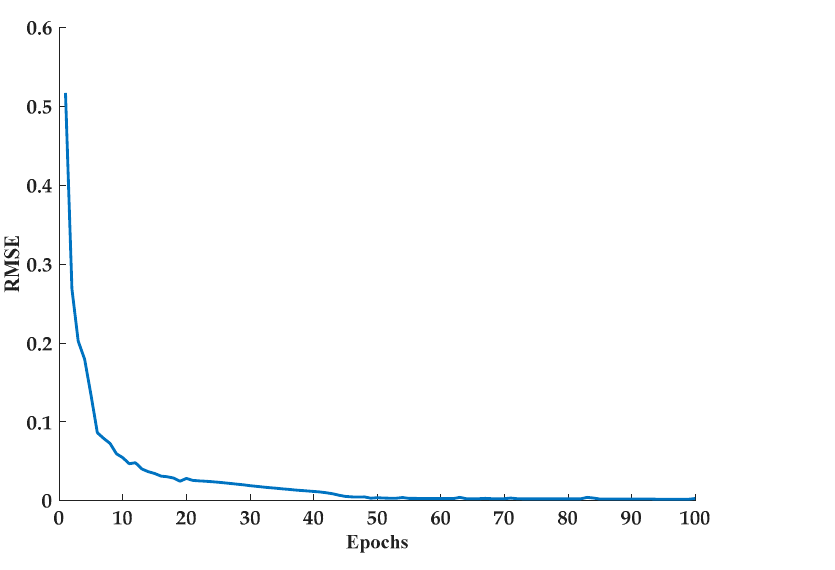
Figure 9. Model training results. Table 3. Confusion matrix of the prediction results.